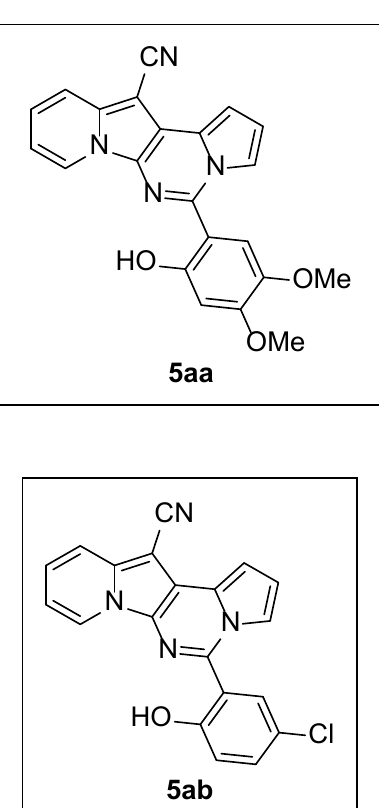
5-(2-Hydroxy-4,5-dimethoxyphenyl)pyrrolo[1 ′ ,2 ′ :1,6]pyrimido[5,4- b ]indolizine-12- carbonitrile (5aa). Yellow solid, mp: 243.7–244.4 °C (29.6 mg, 70%); 1 H NMR (400 MHz, CDCl 3 ) δ 9.86 (s, 1H), 8.56 (d, J = 6.8 Hz, 1H), 7.98–7.95 (m, 1H), 7.76 (d, J = 8.8 Hz, 1H), 7.45 (s, 1H), 7.31–7.27 (m, 1H), 7.16 (d, J = 3.6 Hz, 1H), 6.99–6.92 (m, 2H), 6.72